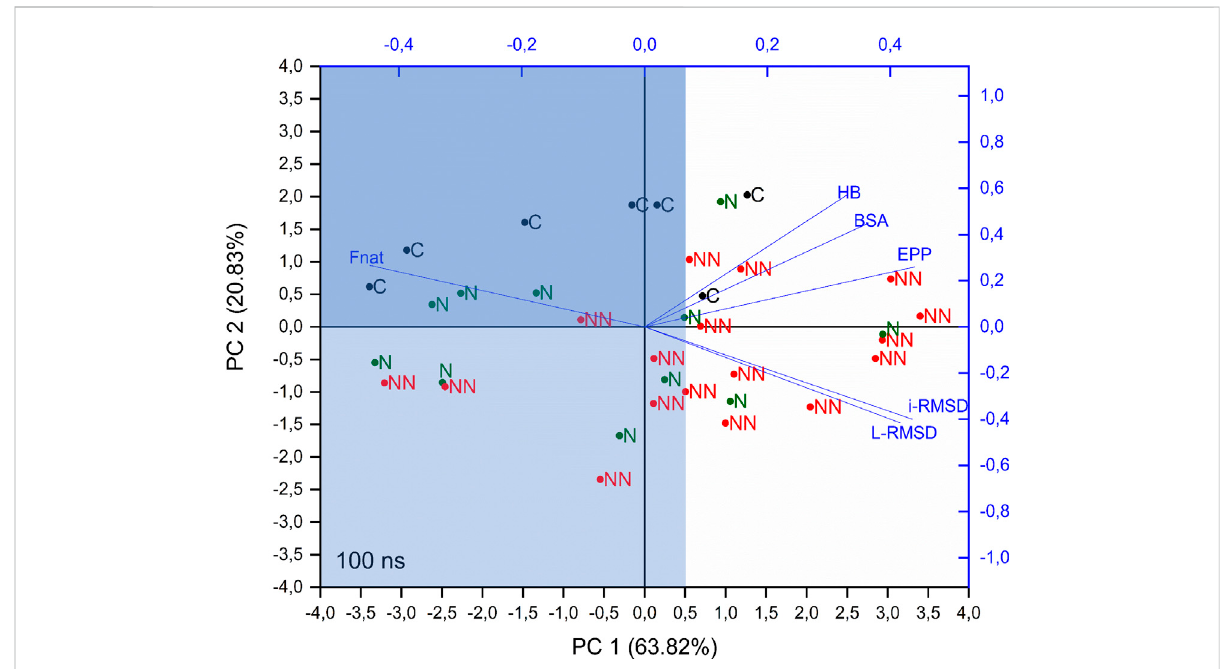
FIGURE 2 PCA biplot of considered parameters. PCA was performed on the correlation matrix of Spearman coef fi cients of CAPRI parameters (average values) and BSA, HB and EPP (rSD), calculated on the whole trajectory. C, N, and NN labels indicate crystallographic structures, Native and Non- Native poses